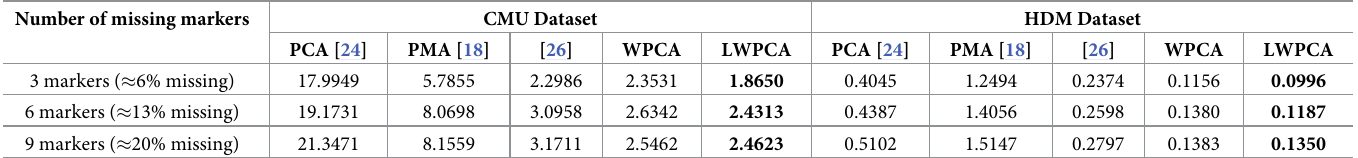
Table 2. Mean recovery errors for missing multiple markers (the small figure indicates small error according to Eq 15). Number of missing markers